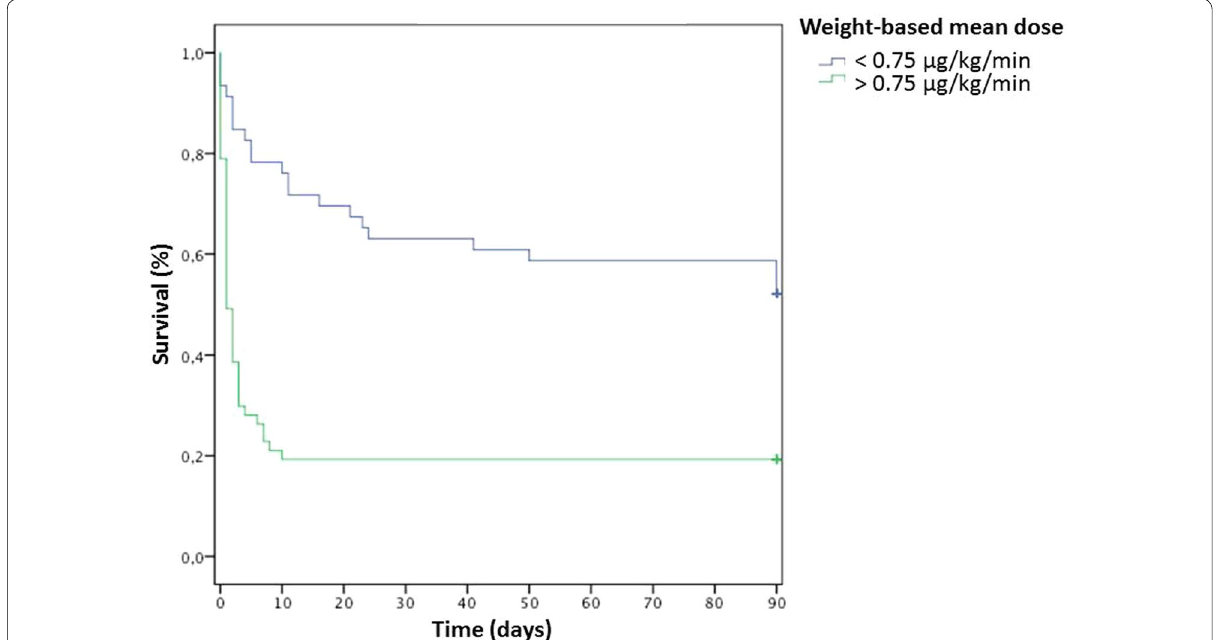
Fig. 4 Survival analysis at 28 days according to a cutoff at 0.75 µg/kg/min of norepinephrine: Kaplan–Meier curve